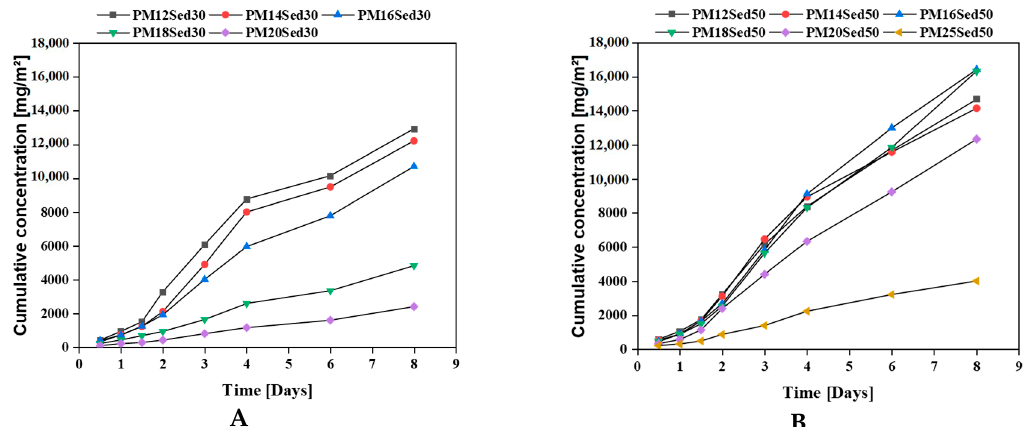
Figure 3. Evolution of cumulative concentration of calcium in leachates from monolithic polymer mortars containing 30% ( A ) and ( B ) 50% of sediments in their matrices.